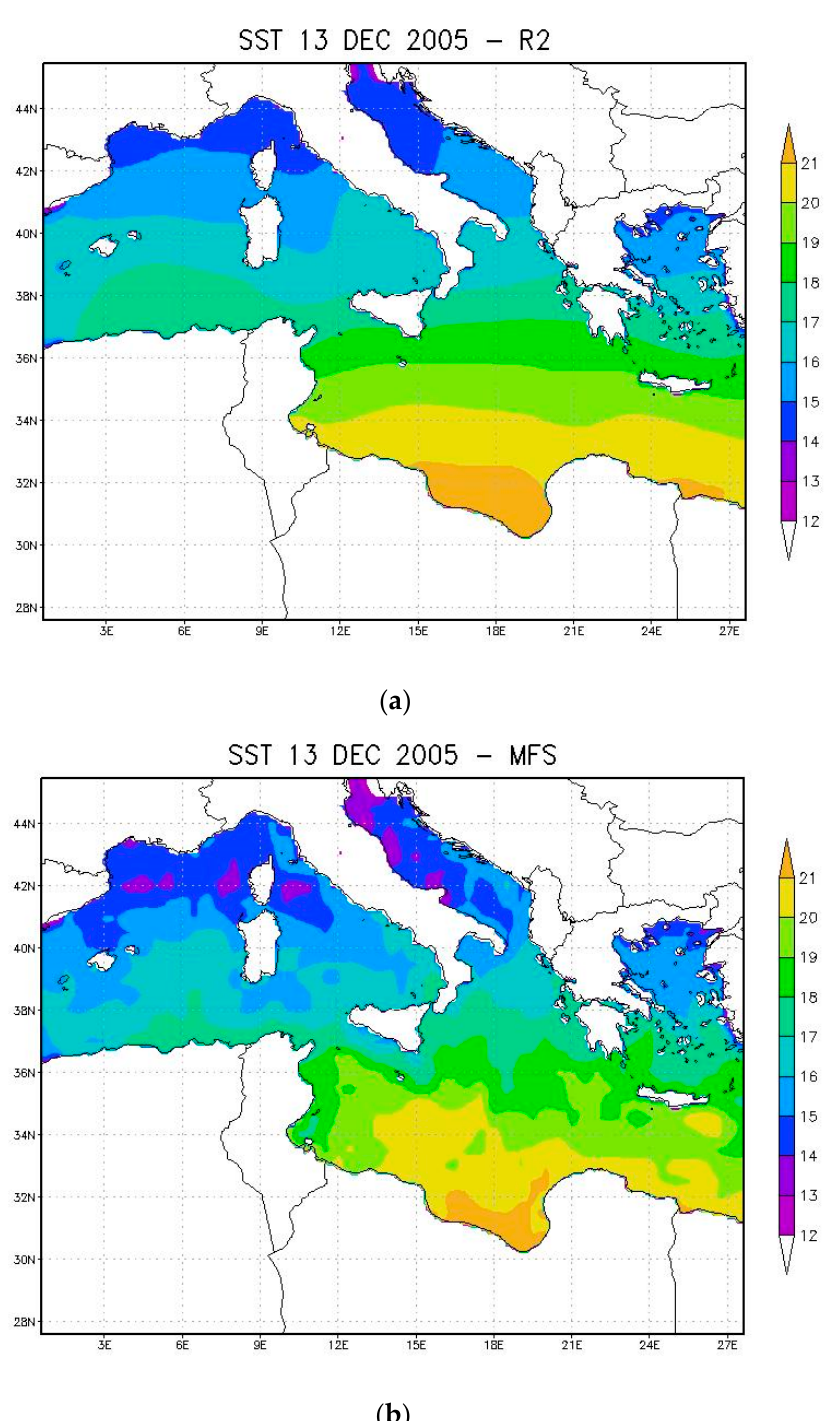
Figure 10. SST (°C) fields on 13 December 2005: ( a ) from the R2 reanalysis and ( b ) from the Medi- Figure 10. SST ( ◦ C) fields on 13 December 2005: ( a ) from the R2 reanalysis and ( b ) from the terranean Forecasting System (MFS) reanalysis for the full model domain. Mediterranean Forecasting System (MFS) reanalysis for the full model